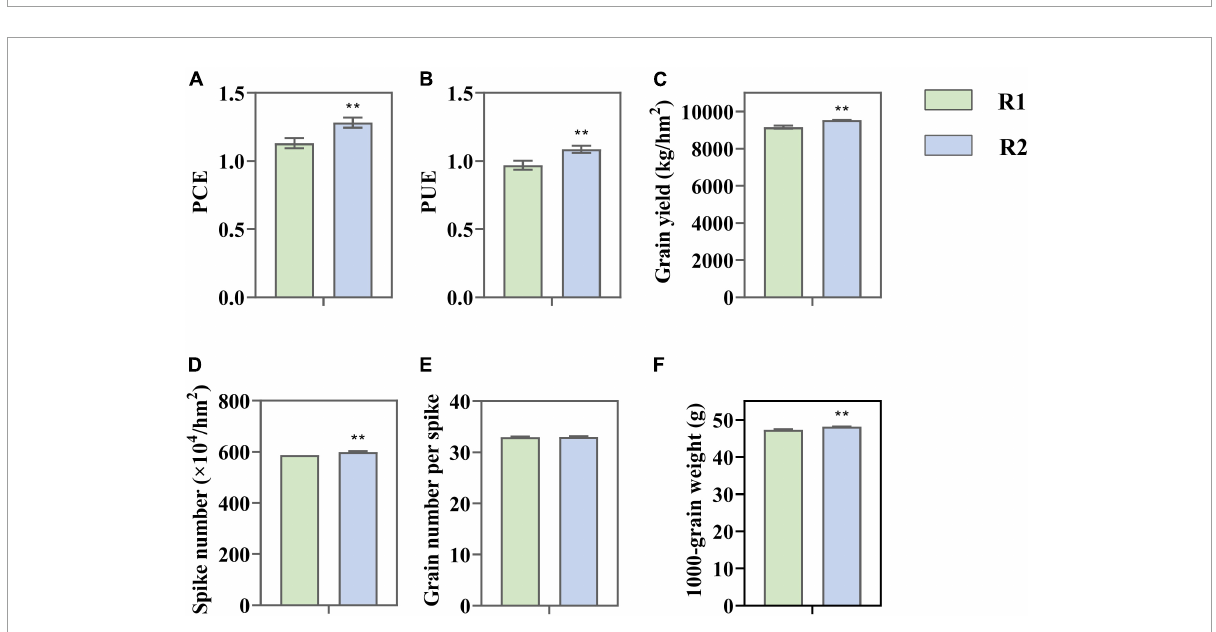
FIGURE2 Change in light conversion efficiency (PCE). (A) Light use efficiency (PUE); (B) grain yield; (C) yield components; (D–F) under different row spacing treatments. Results expressed as mean ± standard deviations (SD); Error bars represent SD. Significant differences marked by asterisks (** p <